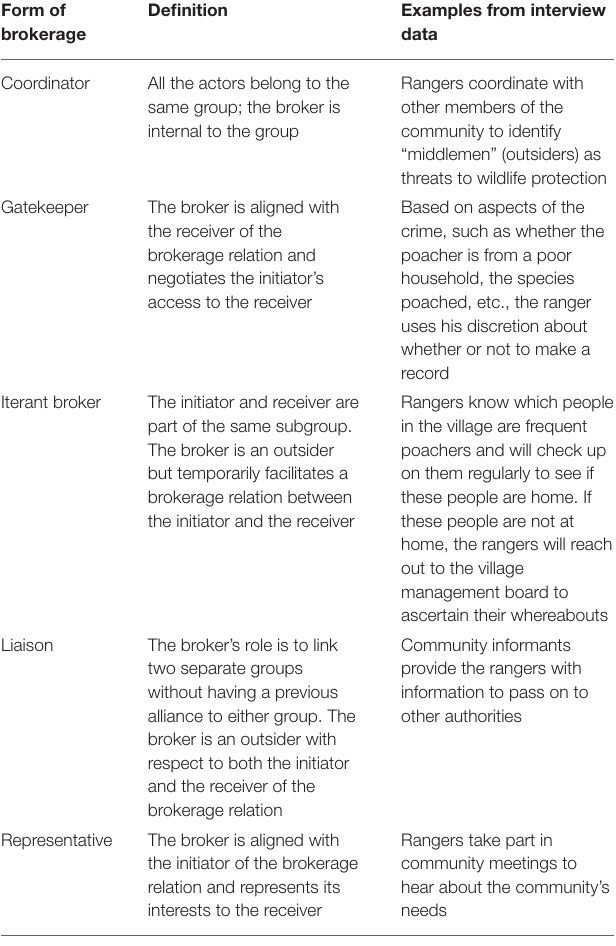
TABLE 3 | Definitions of brokerage, adapted from Gould and Fernandez (1989), and interview-based examples of how respondents function as different forms of